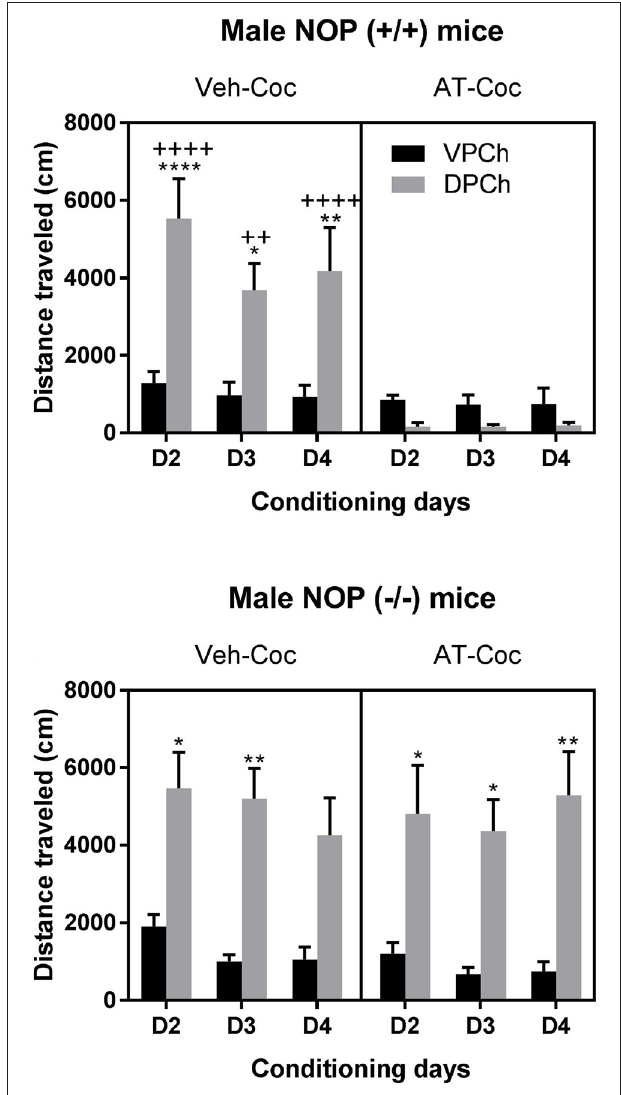
FIGURE 4 | Effects of AT-312 on cocaine-induced motor stimulation during conditioning in wild-type and knockout mice. Motor activity was measured in a subset of animals ( n = 6 mice per genotype for each treatment) and the experiment was repeated three times ( n = 2 mice of each genotype per treatment for each cohort). On each conditioning day, wild-type (Upper) and NOP knockout (Lower) mice were treated with vehicle or AT-312 (3 mg/kg) 5min before cocaine (15 mg/kg, i.p.) and distance traveled by mice in the drug-paired chamber (DPCh) was recorded for 30min each day. The distance traveled by mice in the saline-paired chamber (VPCh) was also recorded, in which mice were injected with vehicle and 5min later with saline. * P < 0.05, ** P < 0.01 and **** P < 0.0001, a significant increase in distance traveled by mice in the DPCh vs. their respective VPCh on this day. ++ P < 0.01 and ++++ P < 0.0001 vs. DPCh in mice treated with AT-312 followed by cocaine on this